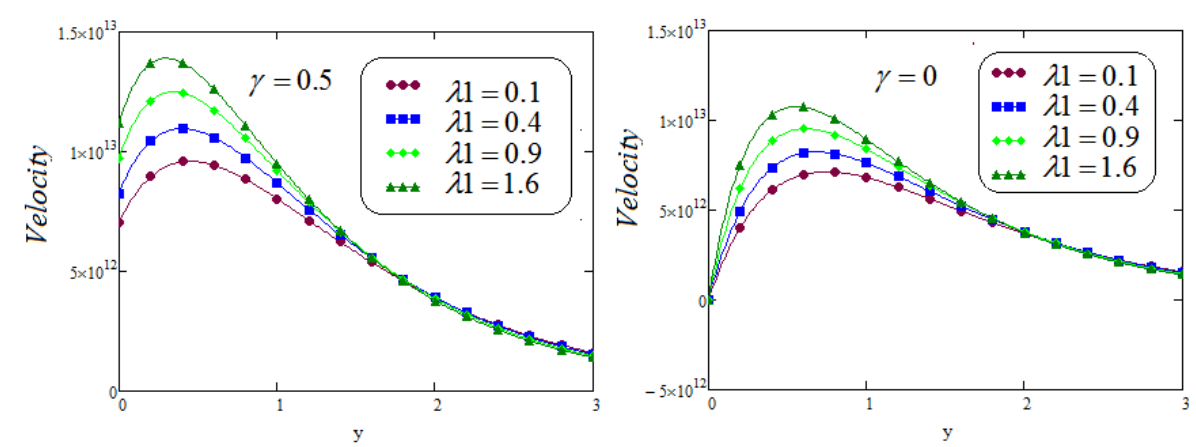
Figure 14. Velocity for varied values of λ 1 with and without slip effect γ when f ( t ) = sint , t = 1.5, Gr = 3.5, α = 0.5, β = 0.3, P r = 0.71, λ 2 = 0.2, M = 2.